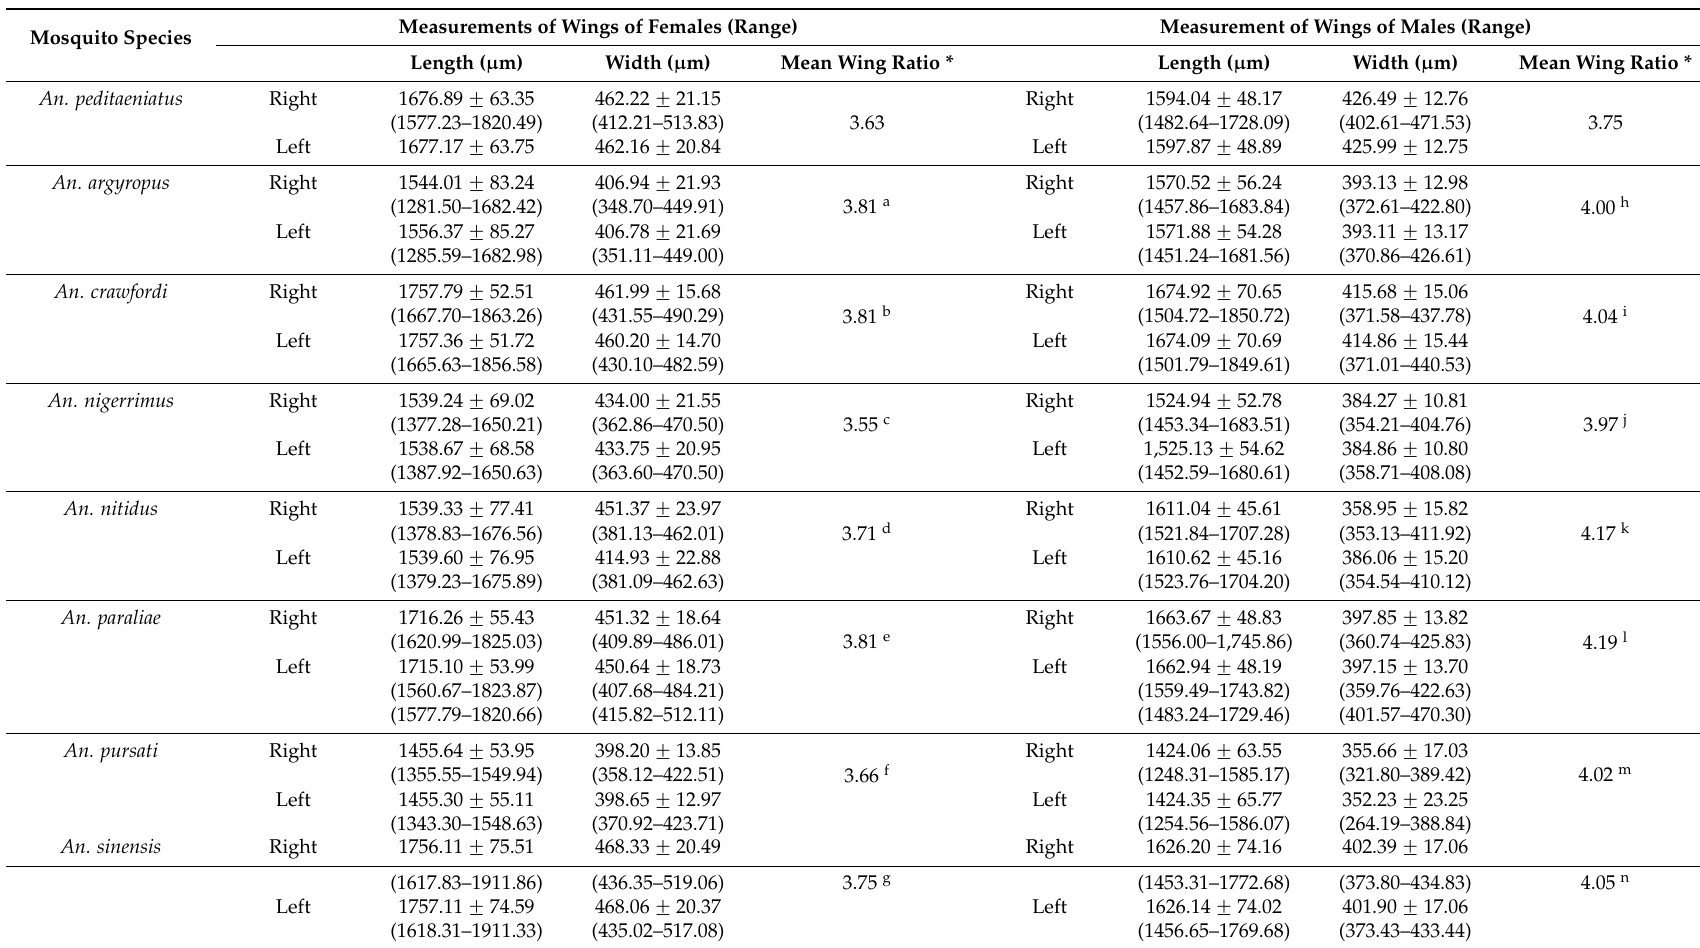
Table 3. Comparisons of mean wing ratios of females and males of the eight species of the Hyrcanus Group (30 females or males/species, n =